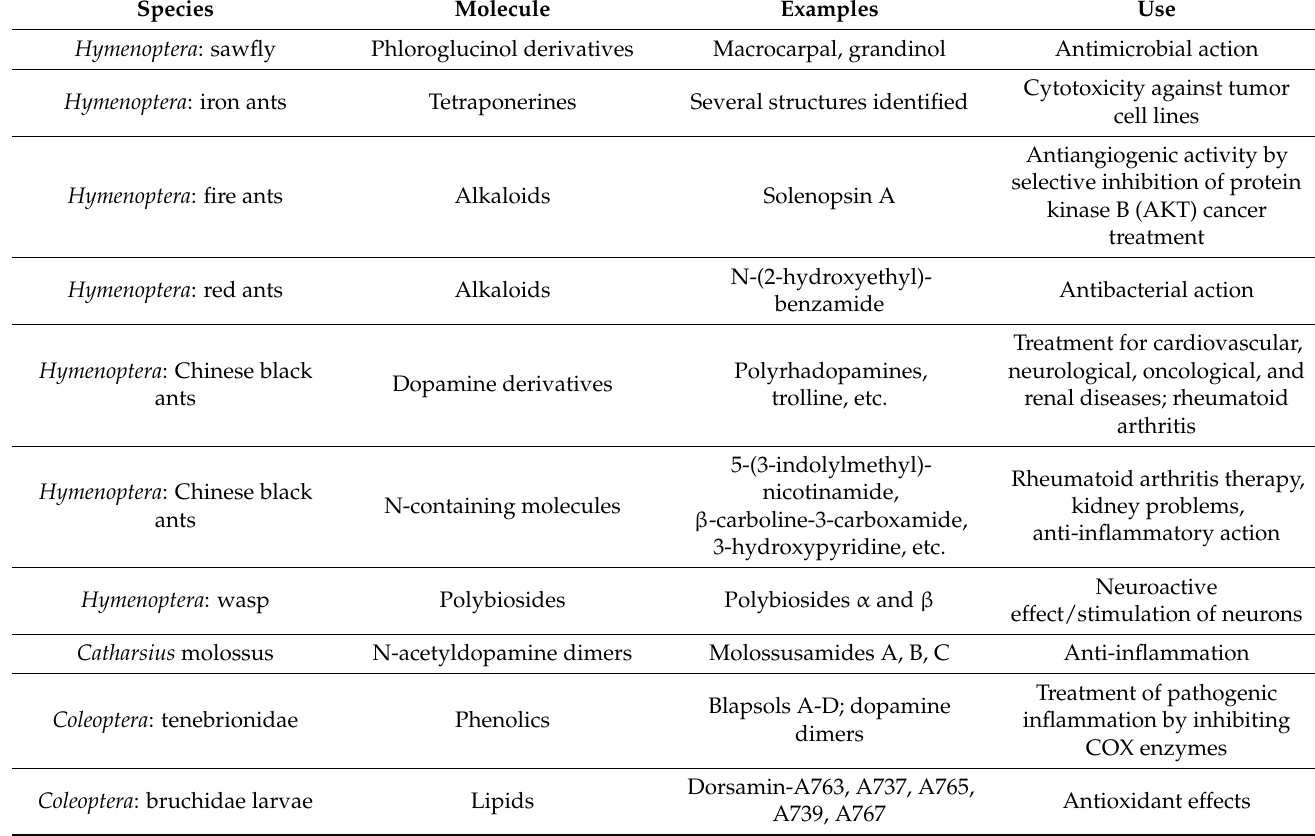
Table 3. Insect-derived small molecules and their potential therapeutic